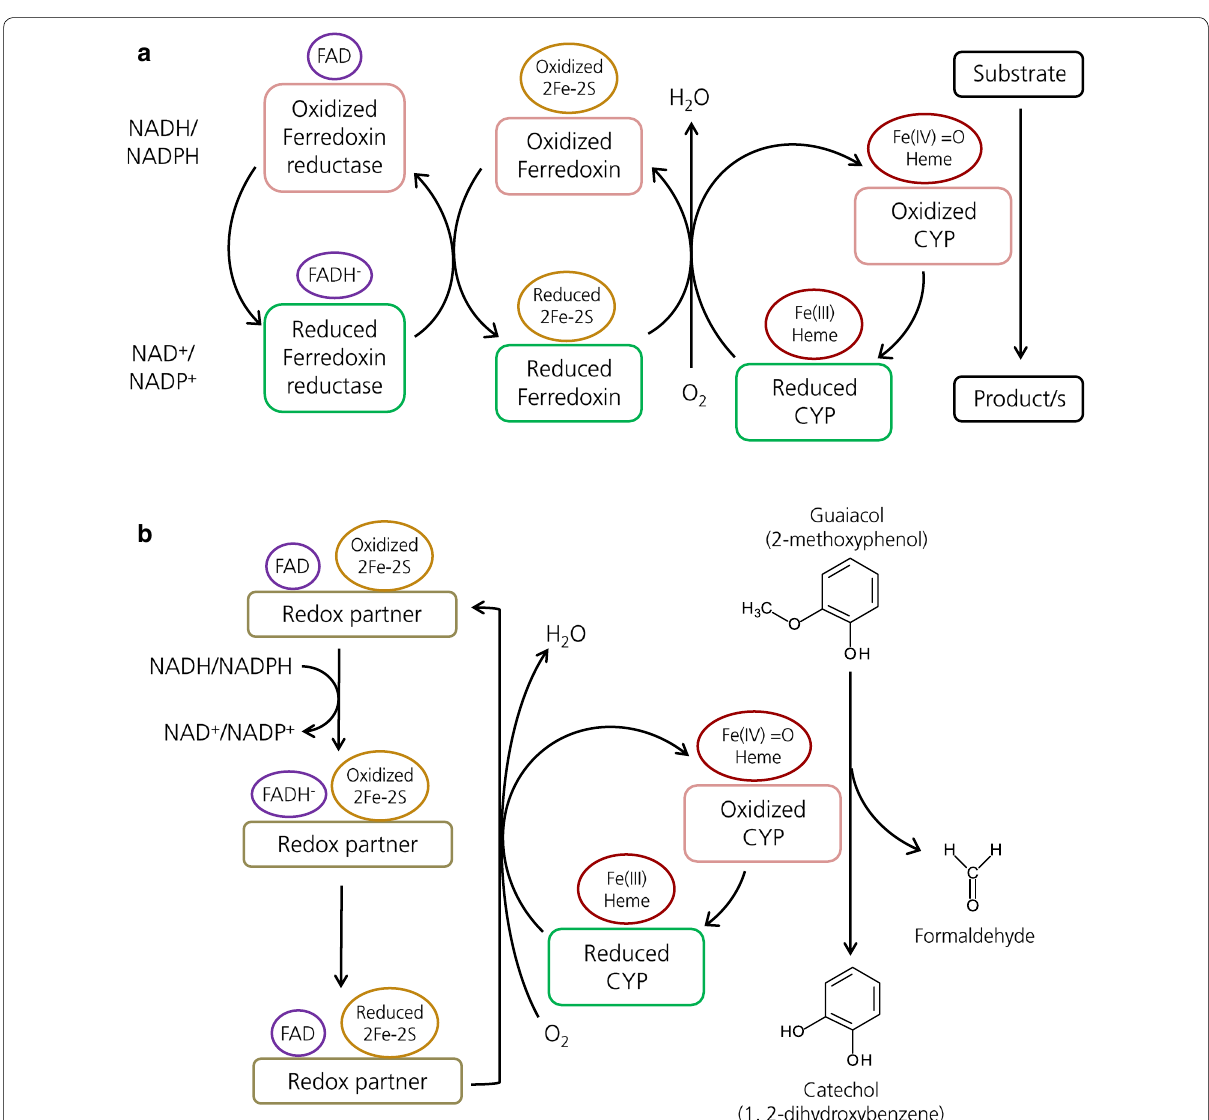
Fig. 1 a General diagram of three‑component CYP systems comprised of a CYP monooxygenase and two redox partners, namely ferredoxin and ferredoxin reductase. Prosthetic groups on each protein as well as their redox state are depicted. b Diagram of the reaction carried out by the guaiacol O ‑demethylation system of Rhodococcus rhodochrous and the electron transport involved between the two